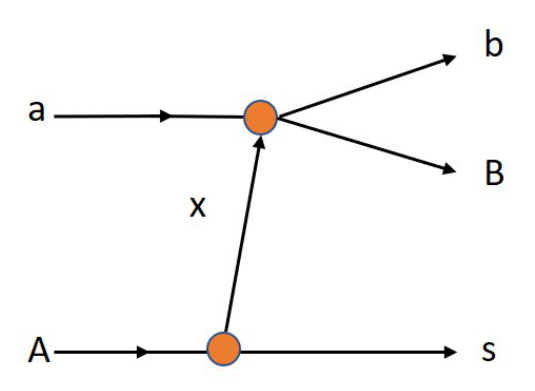
Figure 1: Diagram describing the TH reaction a + A → b + B + s . The upper vertex describes the x + a → b + B two-body process of interest, while the lower one the virtual decaying of A as x ⊕